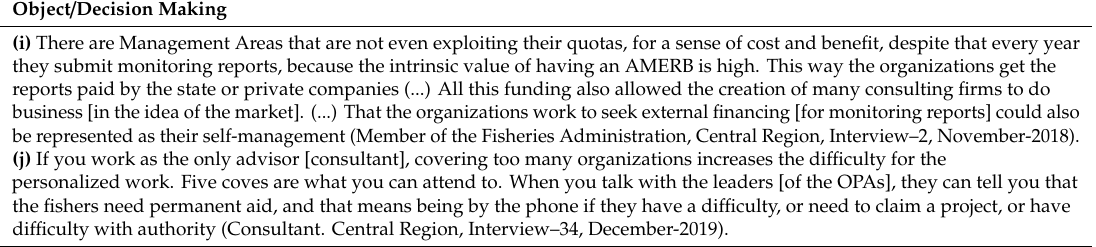
Table 3. Selected quotes from the